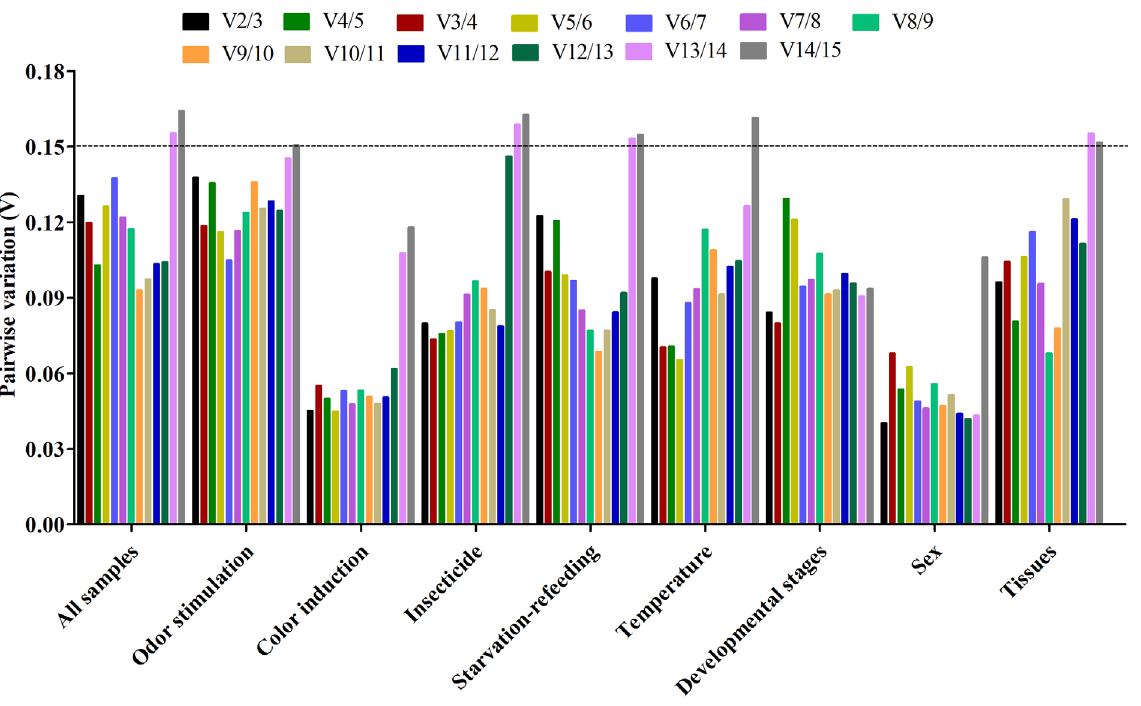
Figure 4. GeNorm analysis of paired variation (V) values of 15 candidate reference genes. Vn/Vn + 1 values are used to determine the optimal number of reference genes. The cut-off value to determine the optimal number of reference genes for qPCR normalization is 0.15.